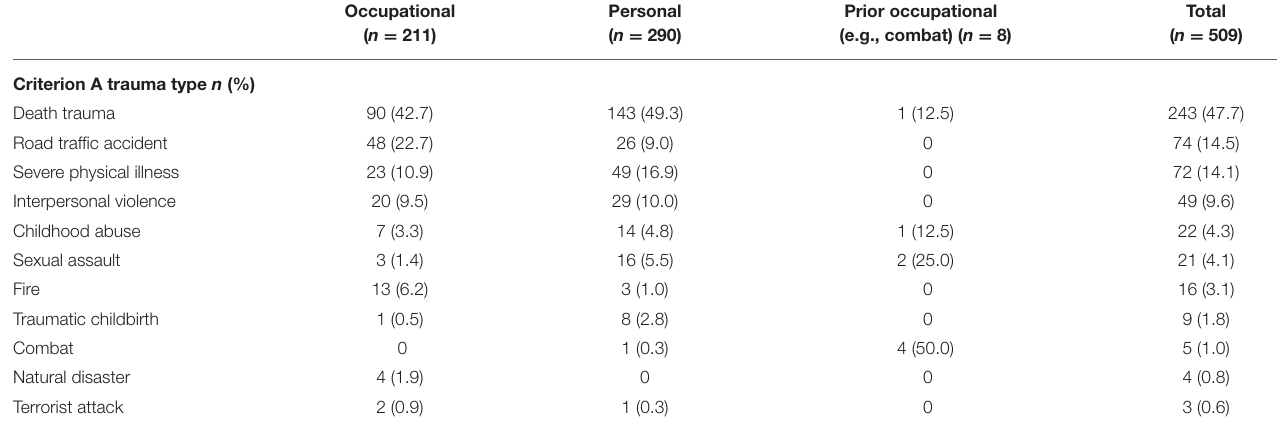
TABLE 4 | Criterion A index trauma